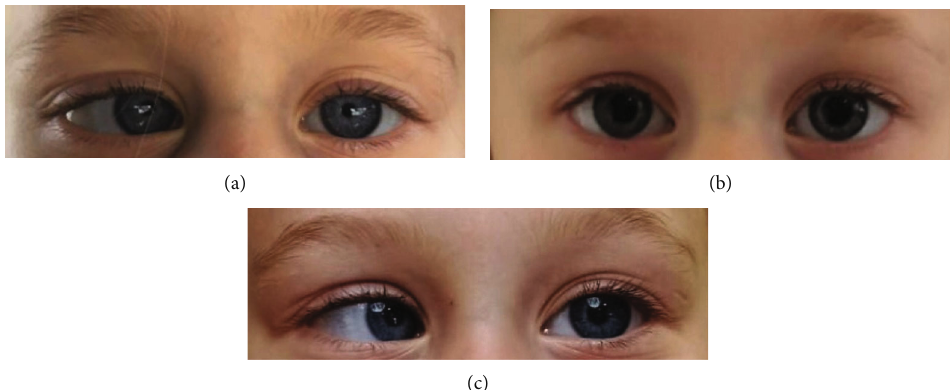
Figure 1: (a) A 3.5-year-old girl with right esotropia on the day of admission. (b) In the next day, the child is orthotropic. (c) She was again esotropic on the third scheduled “ surgery ”